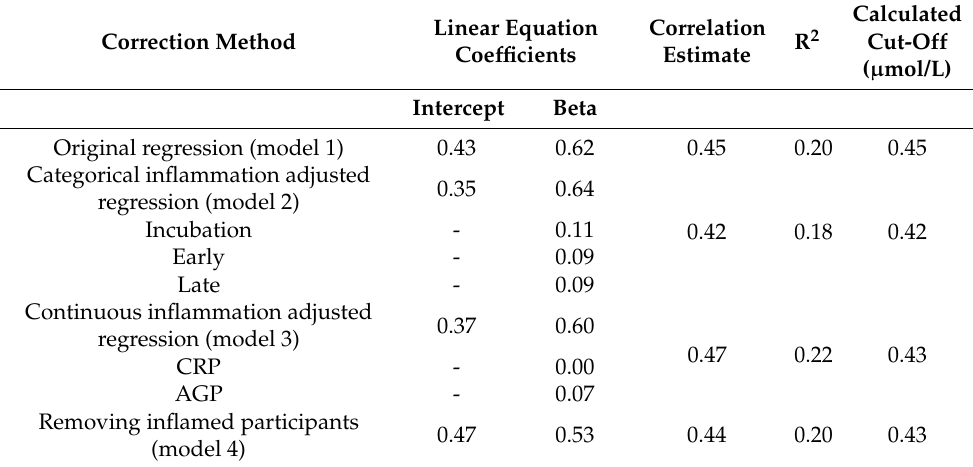
Table 3. Model outputs of the linear regression and correlation coefficients before and after cor- recting for confounders .